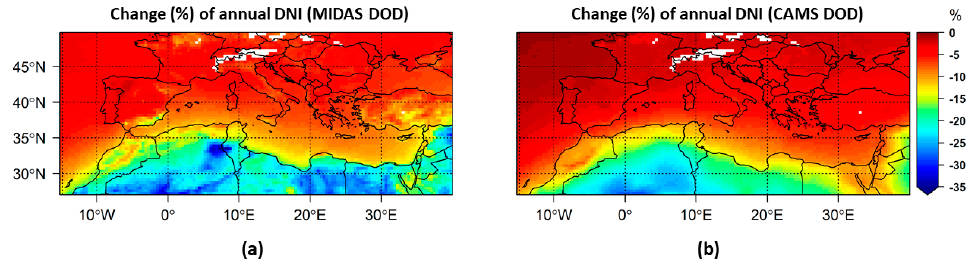
Figure 9. Change (in %) of the mean annual integral of DNI due to the presence of dust under ( a ) MIDAS DOD and ( b ) CAMS DOD. Blank grid points are those that did not fulfill the criterion of at least 20% data availability on annual basis. Table 6. Change (in %) of the regional averaged mean annual and seasonal integrals of DNI due to total aerosols (AOD) and dust (DOD) from both datasets of MIDAS and CAMS. The maximum seasonal value is denoted as bold, emphasizing the peak of the seasonal cycle.